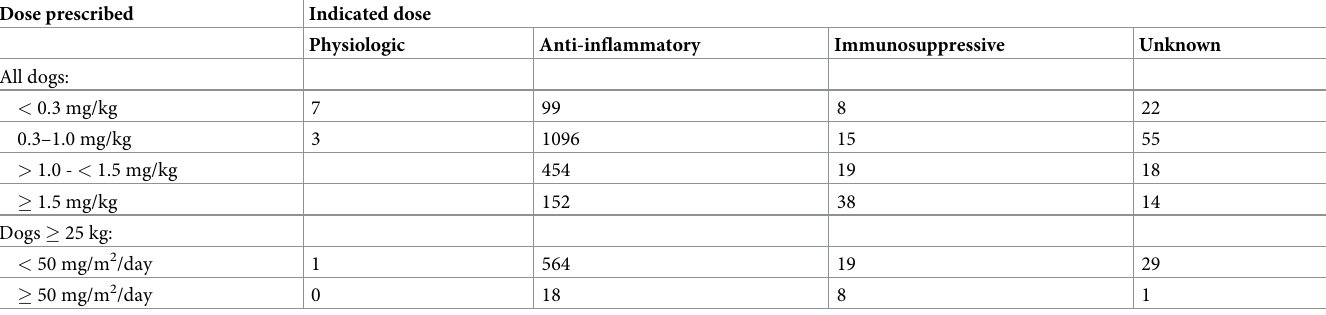
dog for an inflamed mammary mass and one dog for degenerative joint disease. Eight dogs were prescribed appropriately for conditions where an immunosuppressive dose was war- ranted, for one dog the reason for prescription was unclear. Dogs receiving 2 mg/kg/day or greater of prednisolone ( n = 77) were treated for the conditions listed in Table 5. Of the 77 consultations, 28 (36%) were for apparently uncomplicated inflammatory skin or ear conditions. Table 4. Comparison of prescribed prednisolone dose (mg/kg) to indicated dose to 2,000 Australian dogs. Dose prescribed Indicated dose